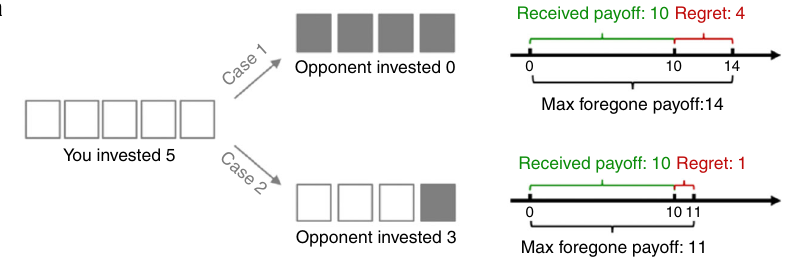
repeated the same choice in round t as in t − 1 was signi fi cantly associated with the size of the payoff ( β = 0.86, Bonferroni 95% con fi dence interval = (0.56,1.17), P < 0.001, Bonferroni corrected; all reported p values are two-tailed), and negatively associated with the size of regret ( β = − 0.45 ( − 0.74, − 0.15), P < 0.001, Bonferroni corrected; Fig. 2b, Table 1).